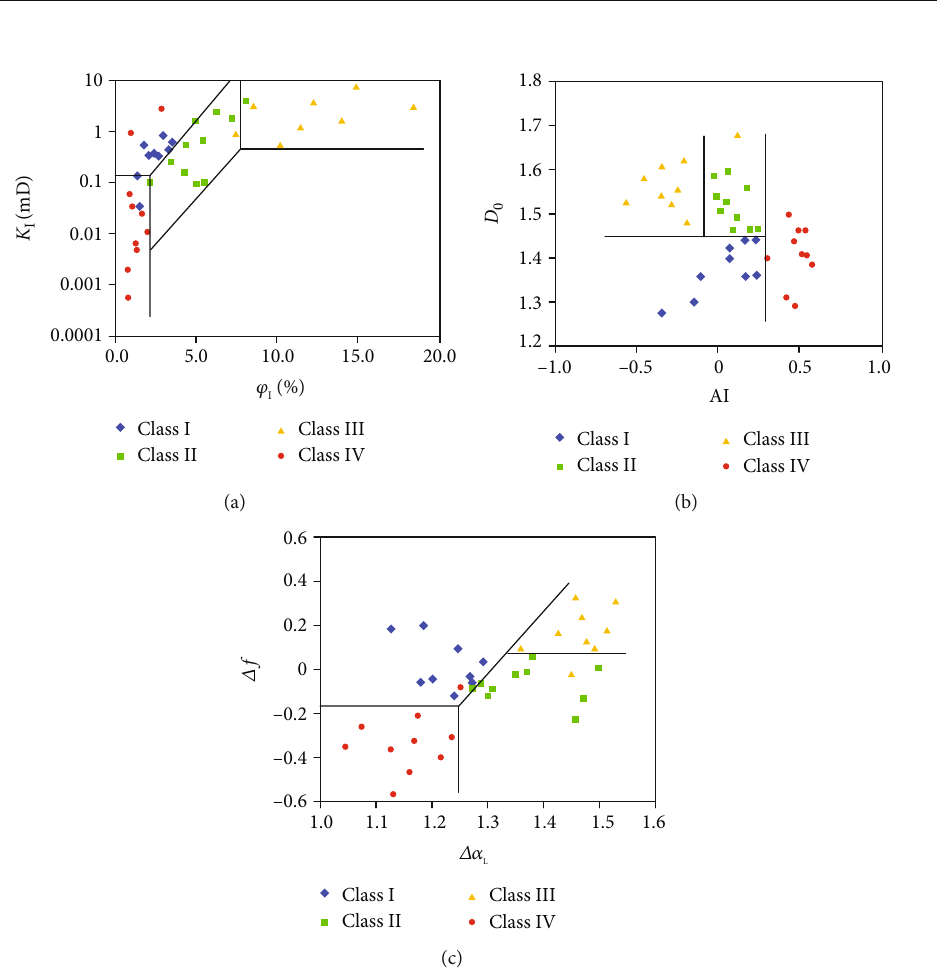
Figure 9: Crossplot of porosity and permeability and multifractal feature parameters of dolomites in di ff erent categories from K -means clustering analysis based on multifractal